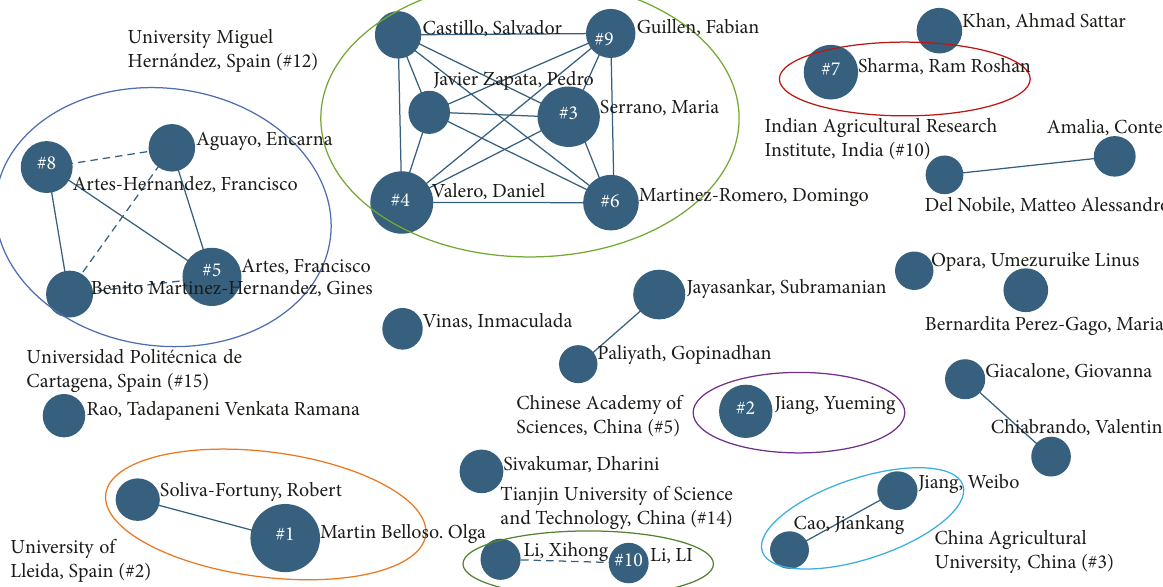
Figure 7: Auto-correlation map of the top 30 researchers and their organizations (nodes numbered one through ten represent the ten researchers with the most publications in descending